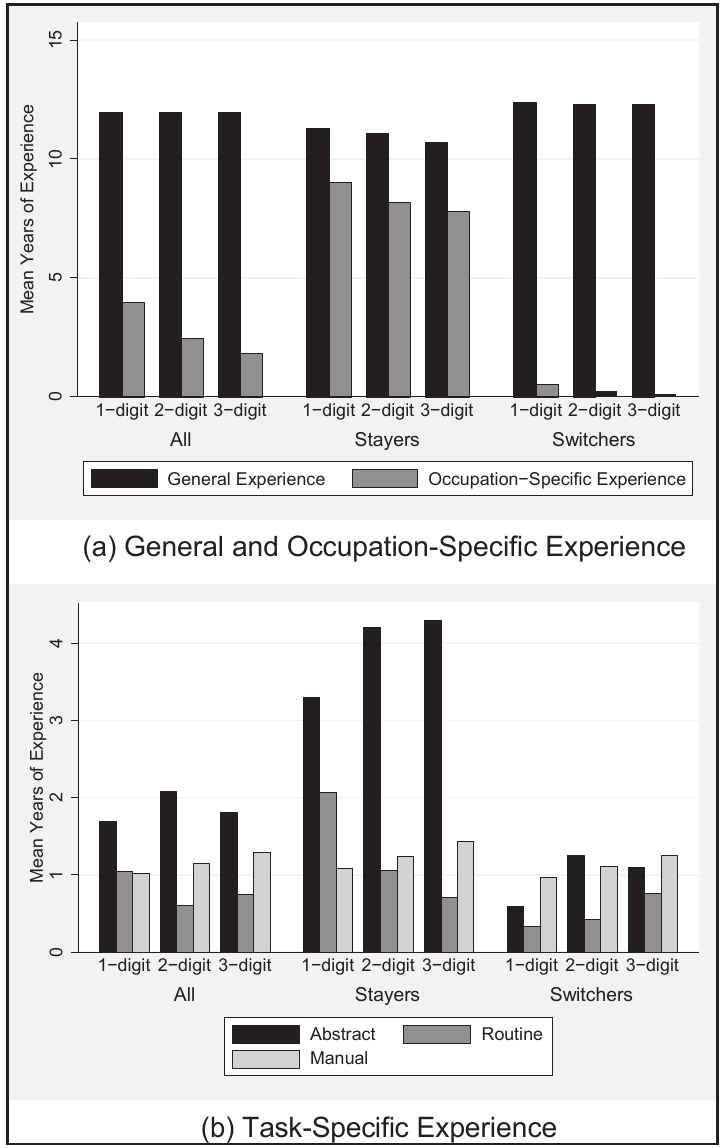
Figure 1 Average experience by sample and digit. Note: (a) General and occupation- specific experience. (b) Task-specific